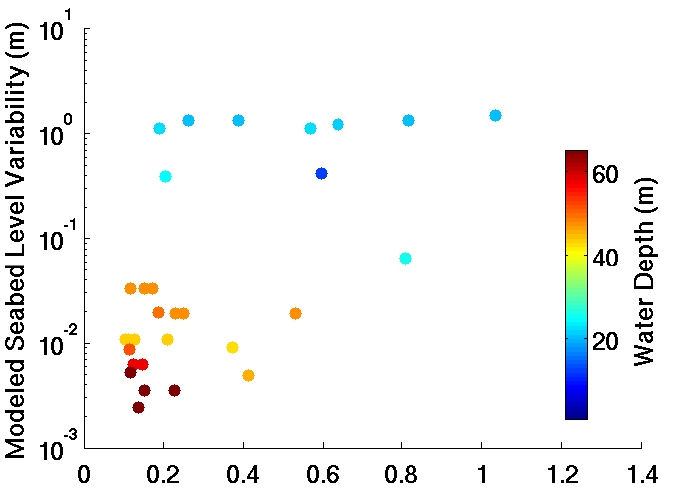
Figure 11. Comparison of seabed level variability to observations of eroded mass from [36] for Gust microcosm erodibility experiments for specific sites. Multiple observations at a single site from were